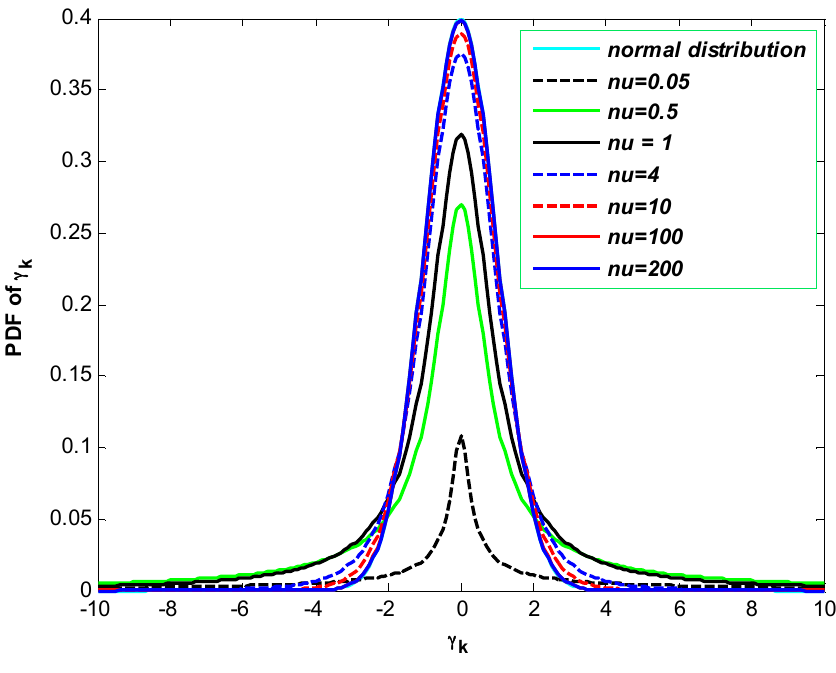
Figure 1. The PDFs of the t -distribution for 0.05, 0.5, 1, 4, 10, 100 and 200 degrees of freedom and the PDF of the standard Gaussian distribution (cyan) related to the measurement noise γ k